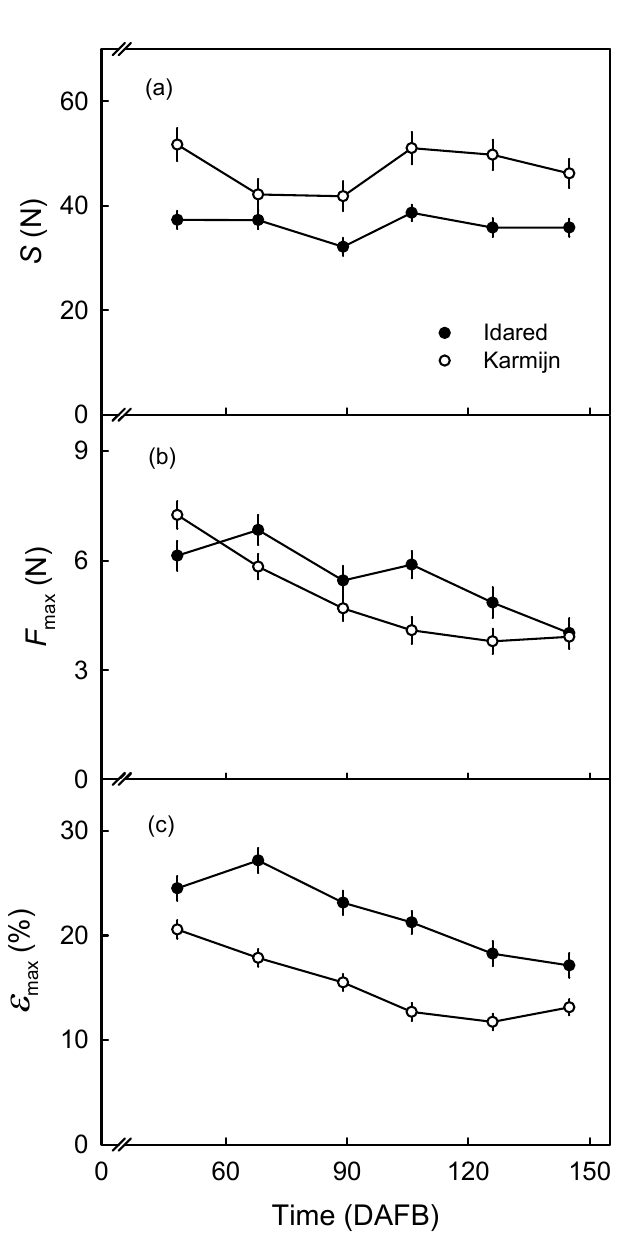
Figure 6. Developmental time courses of change in stiffness ( S ; a ), maximum force ( F max ; b ) and maximum strain ( ε max ; c ) of exocarp segments (ES) of 0.5 mm standard thickness, excised from the equatorial surface of ‘Karmijn’ and ‘Idared’ apples. The number of replicates was 25–35.